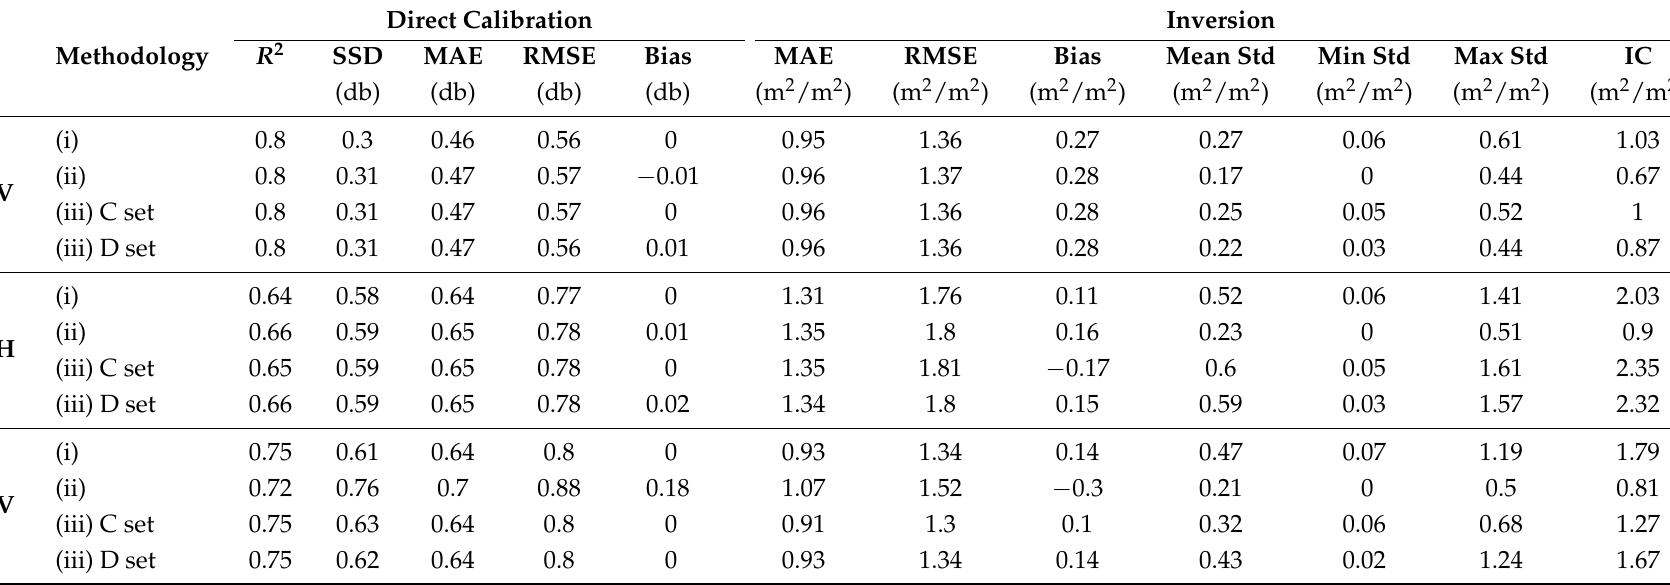
Table 1. Results of the direct calibration and inversion of the water cloud model (WCM) for each polarization and after each methodology of calibration. RMSE on LAI estimation and associated mean, minimum and maximum standard deviations and intervals of confidence (95%) after calibration and inversion of the